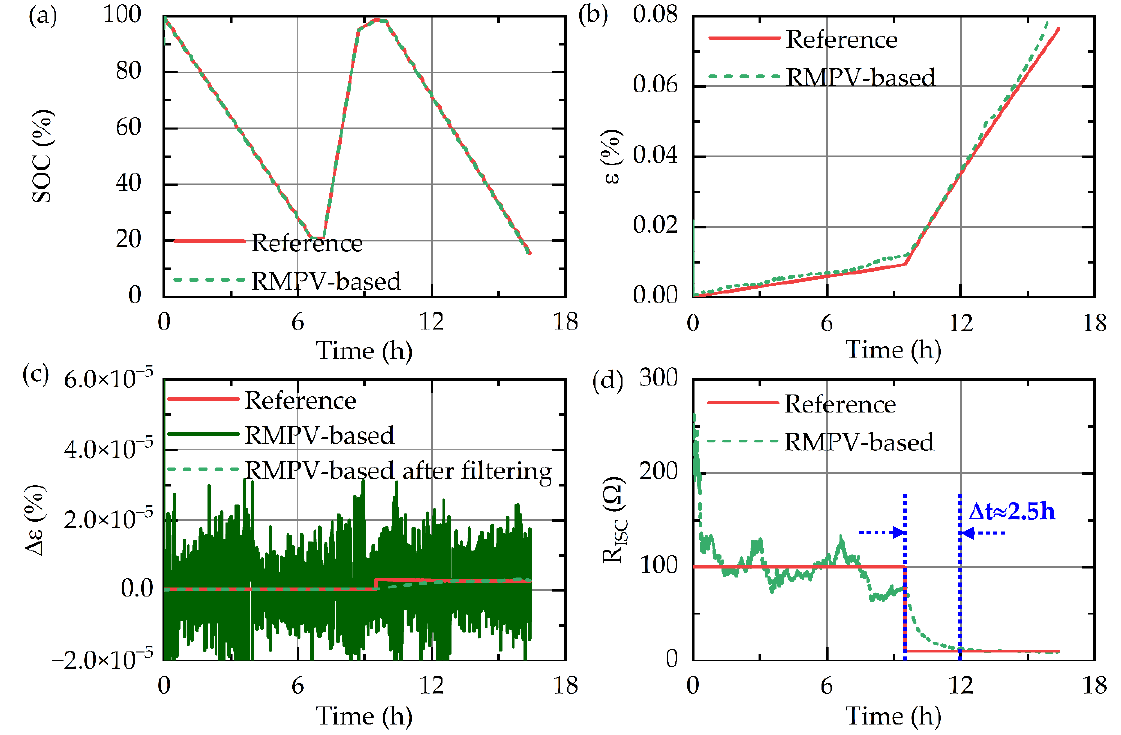
Figure 10. Estimation results with a sudden-changing ER from 100 Ω to 10 Ω : ( a ) SOC estimation result; ( b ) calculation result of ε; ( c ) calculation result of Δε; ( d ) R ISC estimation result.